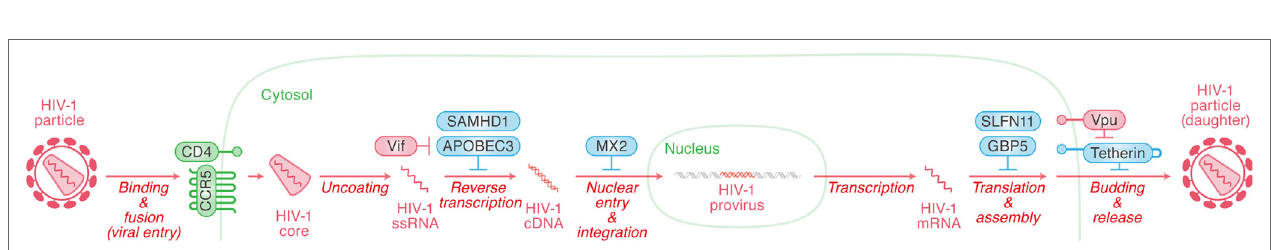
FiGURe 2 | Type I interferons (IFN-I)-initiated signaling pathway leading to interferon-stimulated gene (ISG) expression. Cellular actions triggered by IFN-I [Janus kinase (JAK)/signal transducer and activator of transcription (STAT) pathway] are indicated in purple (in italic) with arrows. Cellular organelle and the cellular molecules related to JAK/STAT pathway are indicated in green and purple, respectively. The detail of each step is described in the main text. “P” with yellow circle indicates phosphorylation.